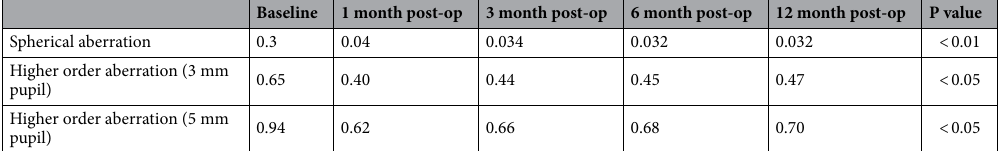
Table 2. Analysis of Spherical aberration and Higher order aberrations at 3 and 5 mm pupil size. *P value for difference between preoperative and 6-month postoperative